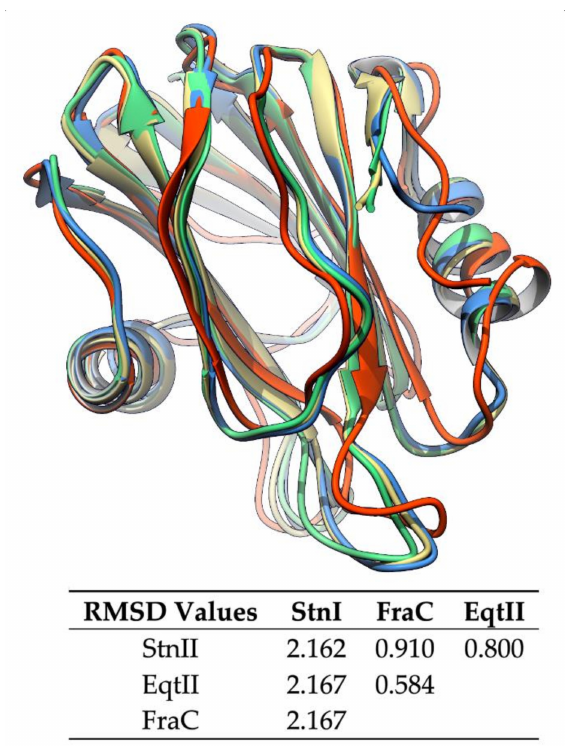
Figure 2. Overlapping structures of the solved actinoporin three-dimensional structures. Sticholysins I (StnI) (2KS4, red) and II (StnII) (1GWY, blue) from Stichodactyla helianthus , fragaceatoxin C (FraC) (3W9P, green) from Actinia fragacea , and equinatoxin II (EqtII) (1IAZ, yellow) from Actinia equina . They share a common characteristic fold, a β -sandwich core flanked by two α -helices. The RMSD values are shown in the table below. Values are much higher when comparison is made against StnI because it is a structure obtained by NMR [127,129], while the other three are crystalline structures